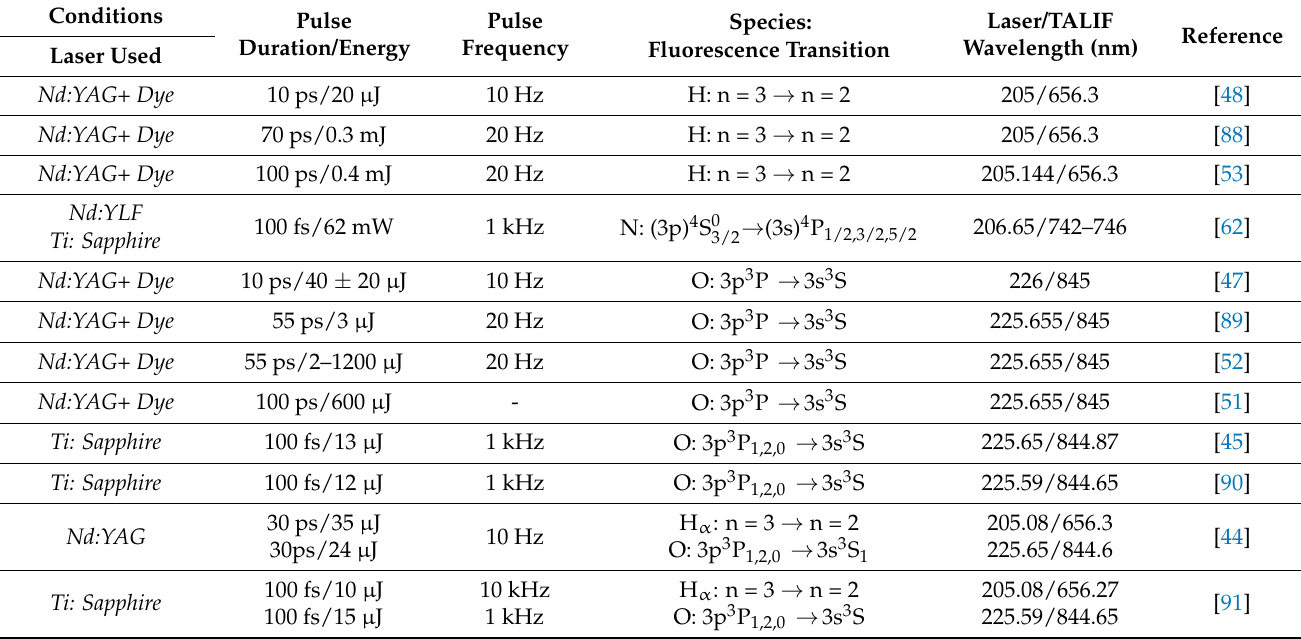
Table 2. Excitation schemes and laser characteristics used in different ps– and fs–TALIF studies to probe the most common atomic species (H, N and O) in plasmas and